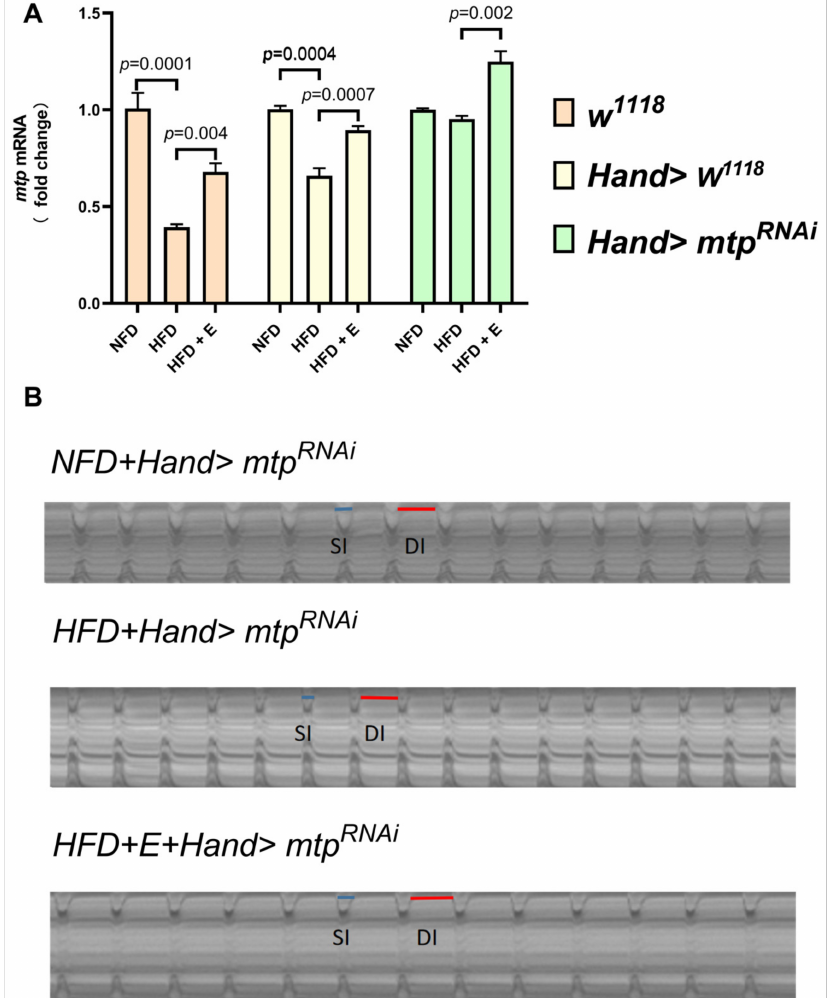
Figure 5. Effects of inhibition of cardiac mtp and exercise training on mRNA expression in Drosophila . All samples (N = 50 per group) were virgin flies of 10 days. ( A ) The cardiac mRNA expression levels of Drosophila under different treatments, on the one hand, HFD decreased the mRNA expression levels of cardiac mtp in the w 1118 and Hand > w 1118 groups; on the other hand, HFD did not significantly affect the mRNA expression levels of cardiac mtp in Hand > mtp RNAi Drosophila . In contrast, exercise training in Drosophila with HFD upregulated the mRNA expression levels of cardiac mtp in all Drosophila of HFD. ( B ) M-mode ECG of Drosophila in the Hand > mtp RNAi group, the blue line is the systolic interval, and the red line is the diastolic interval. In (A), one-way ANOVA was used to identify differences between strains of Drosophila NFD, HFD and HFD +E. LSD was used for post hoc